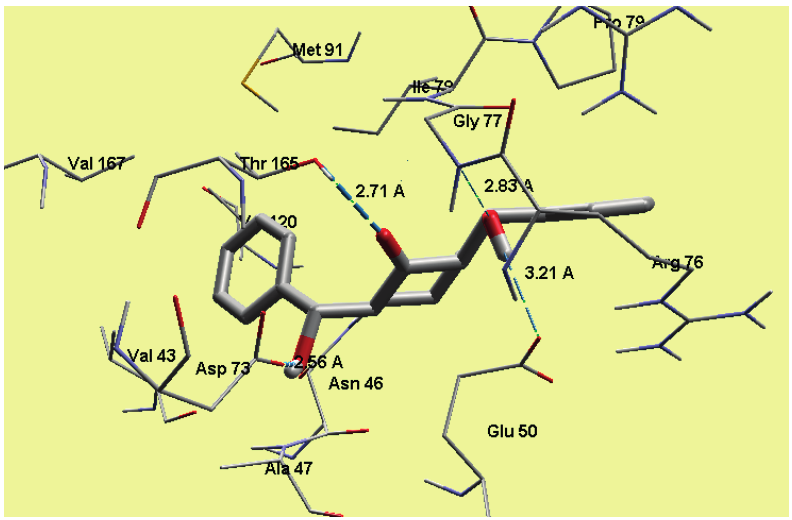
Figure 12. Interaction of compound 1 with the active site of E. coli 24 kda domain.